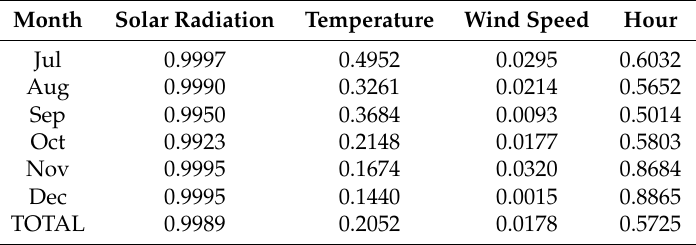
Table 6. The determination coefficients (R 2 ) of every input from MCS.